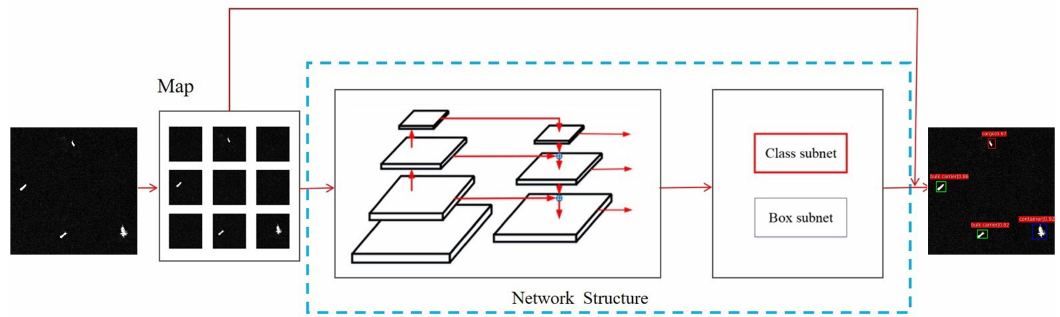
Figure 1. The diagram of our presented method.